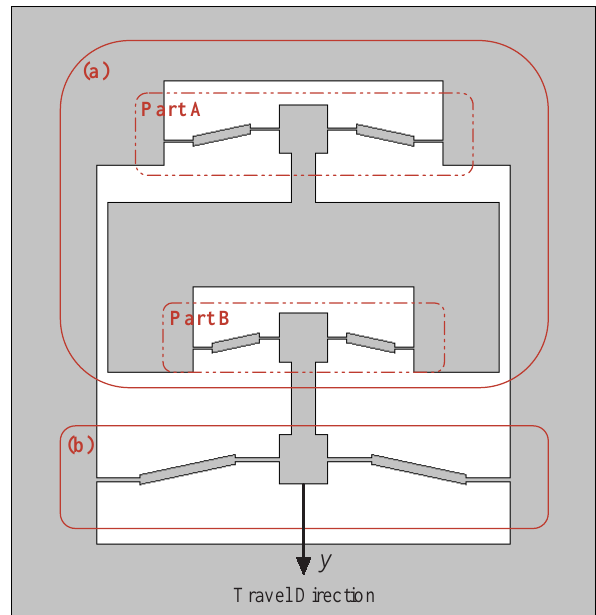
Figure 5. Schematic diagram of a fully-compliant statically- balanced mechanism consisting of two multistable building blocks, i.e., a tristable mechanism and a bistable mechanism. (a) The tristable mechanism consisting of two di ff erent bistable mecha- nisms (i.e., Part A and Part B) connected in series, and (b) the bal- ancing bistable mechanism.